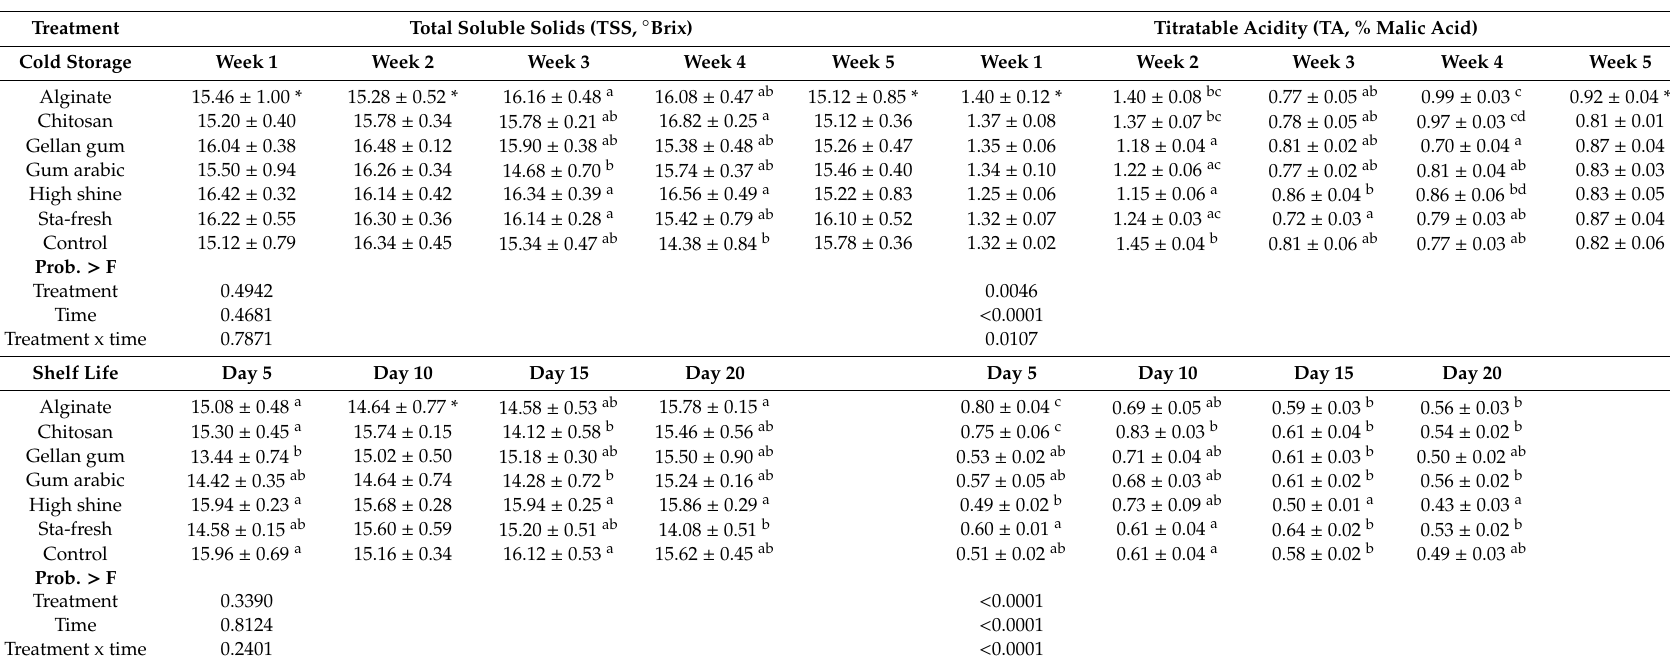
Table 4. Total soluble solids (TSS, ◦ Brix) and titratable acidity (TA, % malic acid) in plums (‘African Delight ™ ’) during a simulated shipping period (cold storage; − 0.5 ± 2 ◦ C and 90 ± 5% RH for 5 weeks) and shelf life (20 ± 2 ◦ C and 75 ± 5% RH for 20